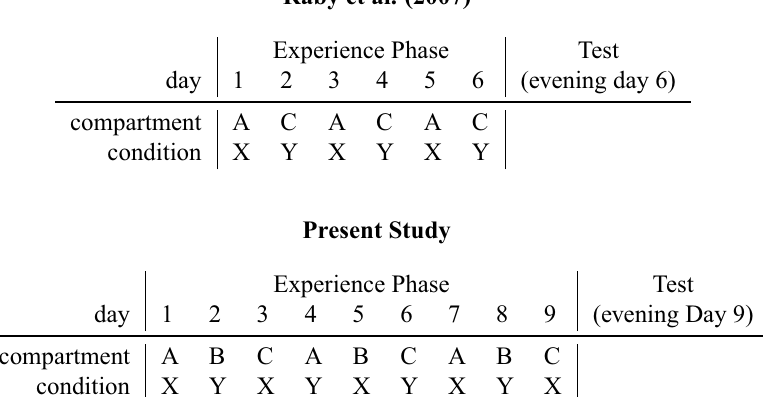
Figure 1. Experimental protocols. In the experience phase, on each day the birds could access one of the compartments (A, B or C) under either condition X or Y. In Experiment 1 of Raby et al. 9 and in Experiment 2 of the present study, condition X means that no food is provided, while condition Y means that food is provided (or the other way around). In Experiment 2 of Raby et al. 9 and in Experiment 1 of the present study, condition X means that a specific type of food is provided, while condition Y means that a different type of food is provided. In the protocol of Raby et al. 9 , each compartment is always experienced under the same condition. In the study reported here, each compartment is experienced under both conditions. Note that in the figure, the two experimental compartments for the protocol of Raby et al. 9 are labelled as ‘A’ and ‘C’ (rather than as ‘A’ and ‘B’) to ensure consistency with the original